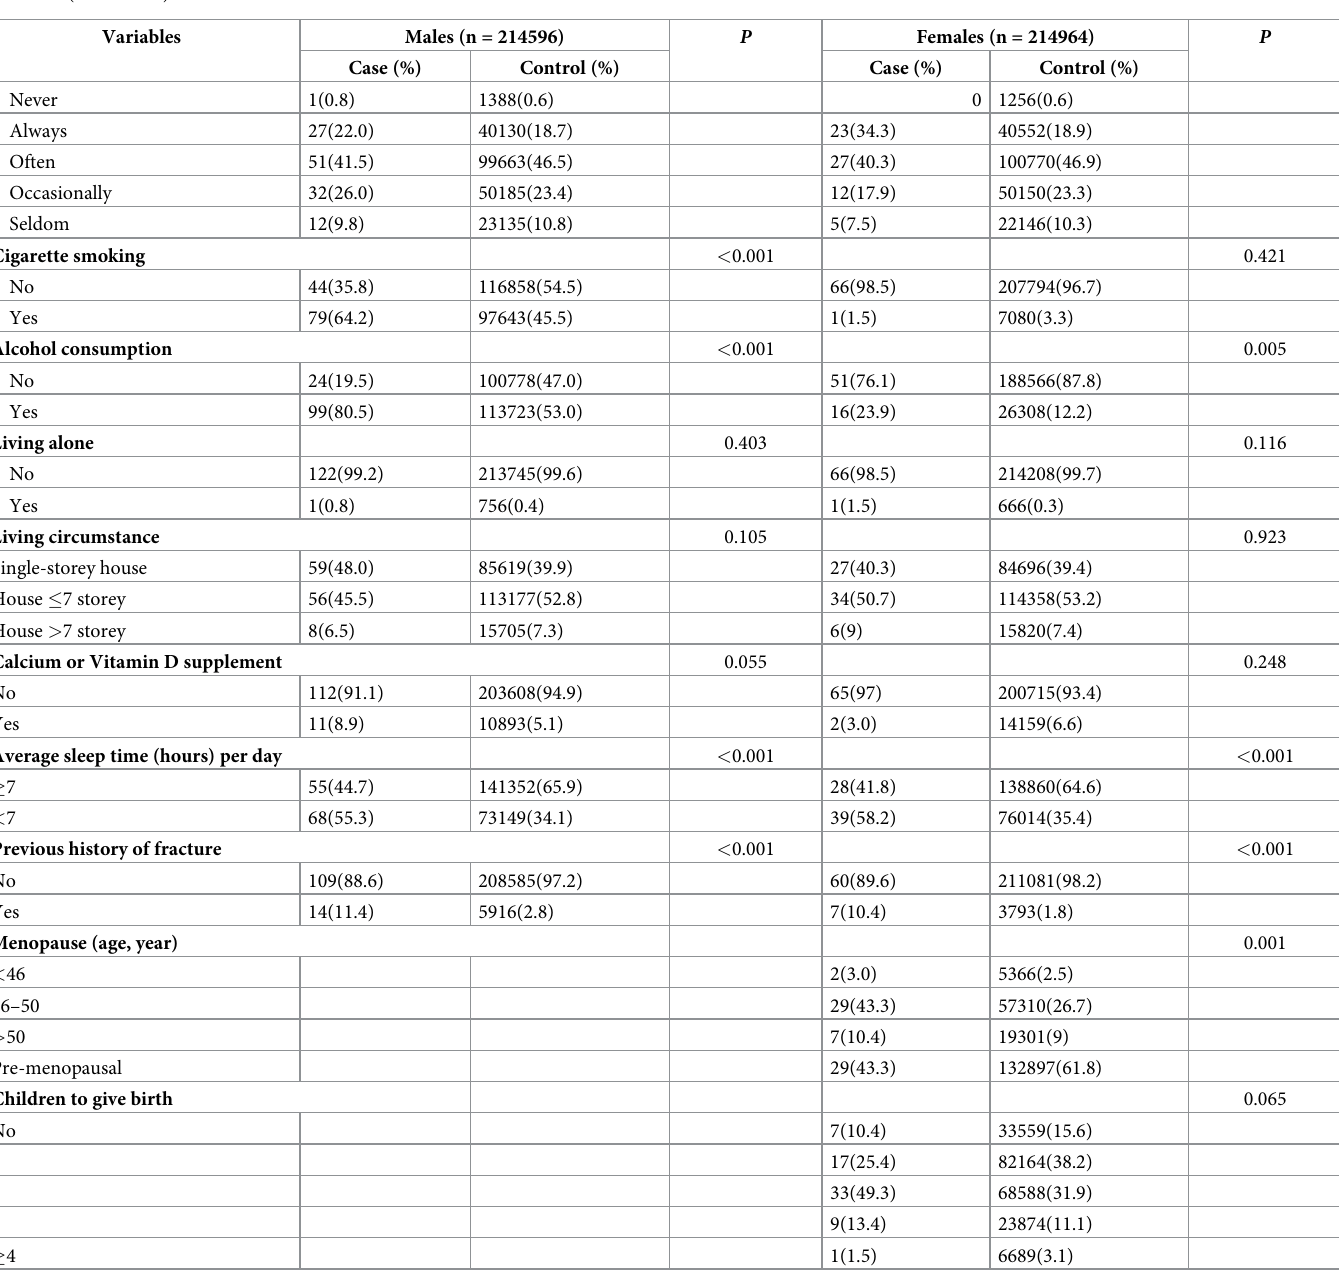
Table 5 presented independent risk factors for traumatic foot fractures in adults by gender. For males, alcohol consumption and cigarette smoking increased the risk of foot fracture by 3.00 times (95%CI, 1.90–4.74) and 1.59 times (95%CI, 1.08–2.33), respectively. And compared to those having enough sleep time ( � 7h/d), average sleep time < 7h/d increased the risk of foot fracture by 2.18 times (95%CI, 1.53–3.13). In addition, history of previous fracture was identi- fied as an independent risk factor for occurrence of foot fractures (OR, 3.82; 95%CI, 2.18– 6.69).Similarly for females, alcohol consumption, average sleep time < 7h/d and history